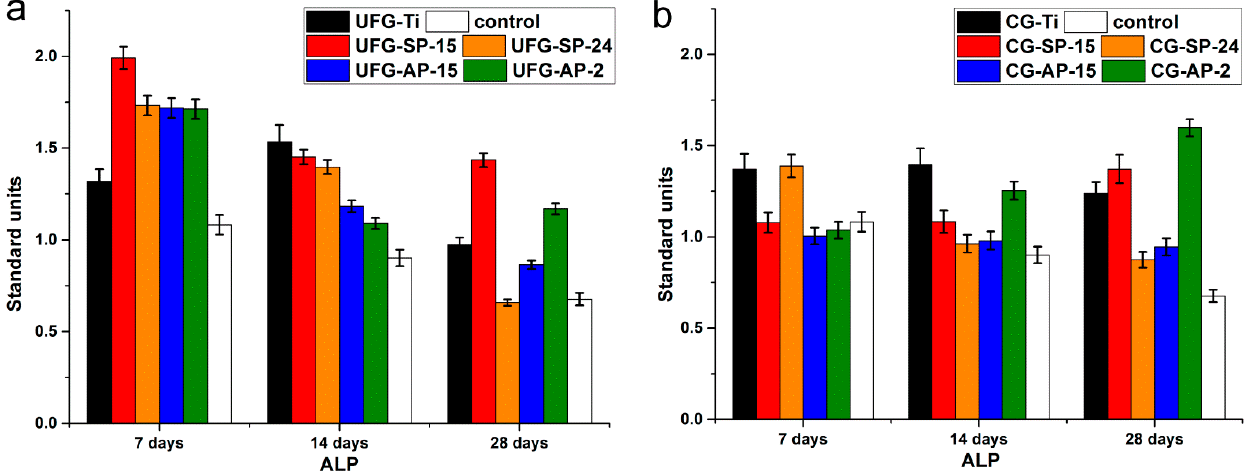
Figure 7. Alkaline phosphatase production by MC3T3 ‐ E1 osteoblasts on UFG series—( a ) and CG series—( b ). Each value represents mean ± S.D. from five independent experiments ( p < 0.05).